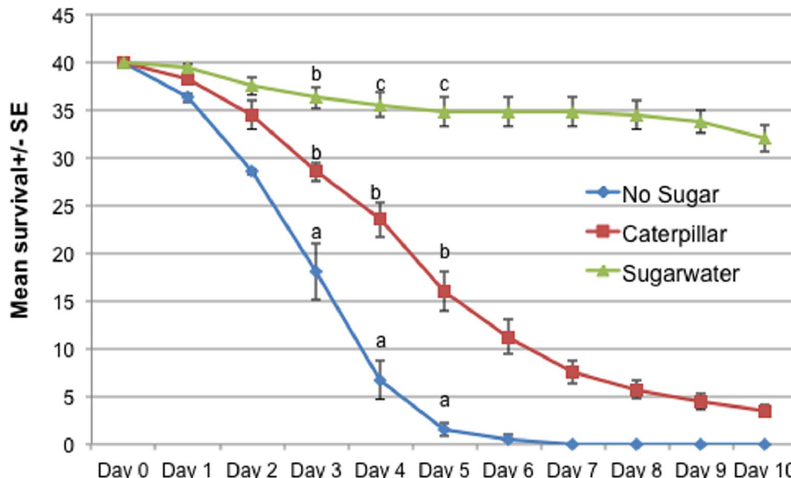
Figure 6. Cage assays examining relative survivorship of female An.stephensi feeding on caterpillar haemolymph. Forty mosquitoes were introduced into each cage. The caterpillar treatment cage contained three fourth instar Heliothis subflexa caterpillars (N=160). Treatments were significantly different on day 4 and day 5. GLM was used to examine the difference between treatments on each day. Treatments with different letters above them are significantly different on each separate day.